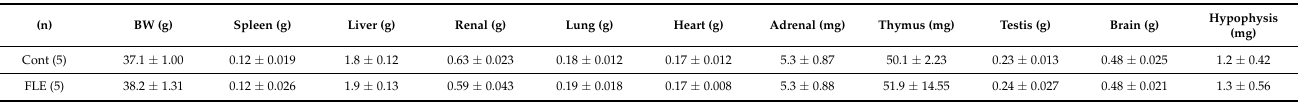
Table 14. Influence of repeated oral administration of FLE (0.166 g/kg/day) to male ddY mice on body weight and organ weight.